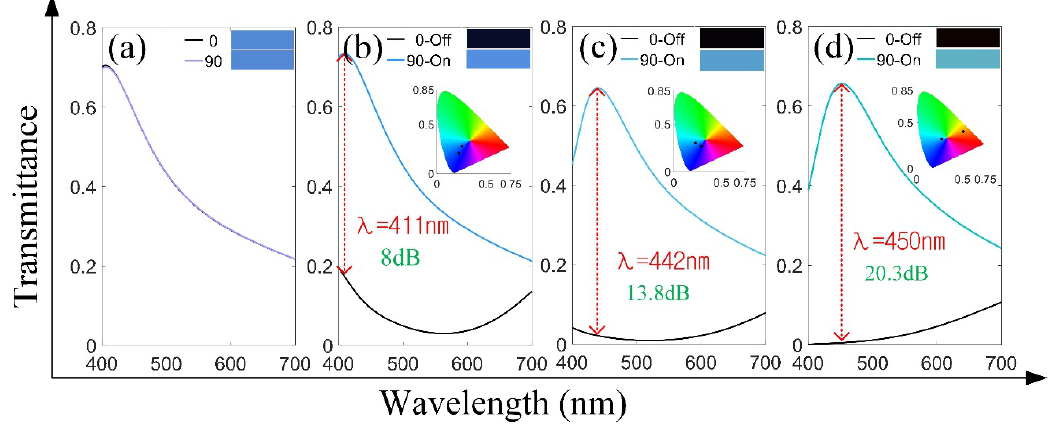
Figure 2. Transmittances of different polarization directions (Parallel to X-axis is 0°; Perpendicular to X-axis is 90°) under the different number of metal strips. ( a ) Hollow circular hole; ( b ) one metal strip; ( c ) two metal strips; ( d ) three metal strips. The inset is CIE1931 color space inversion map distribution.